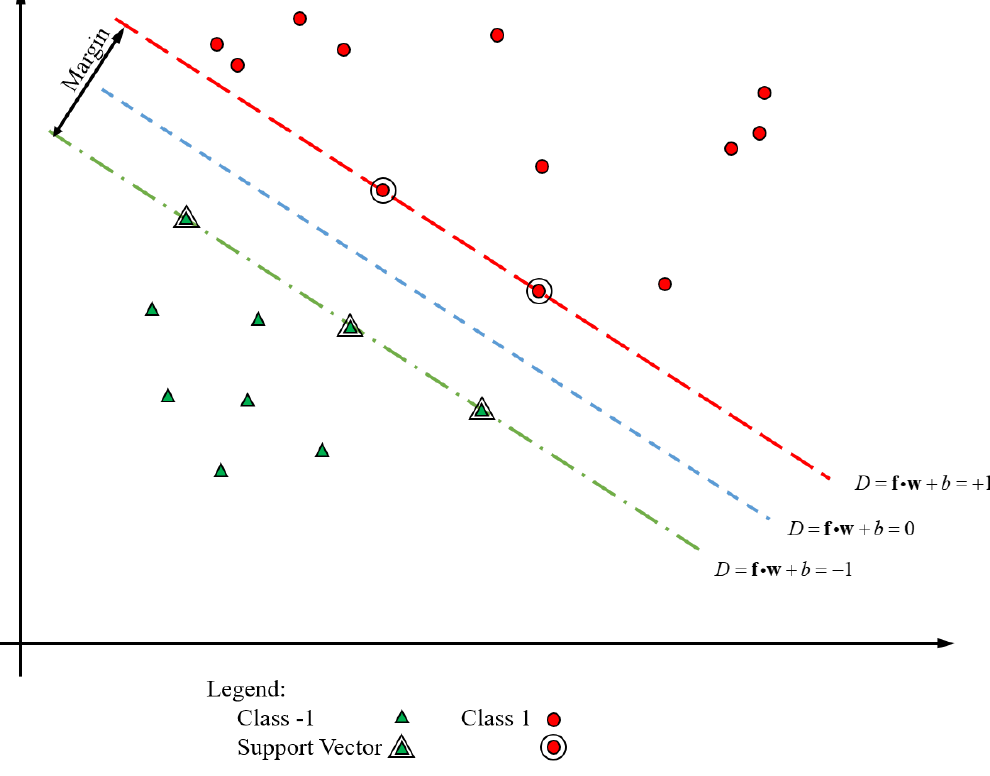
Figure 13. SVM 2D example. The margin is the distance from the D = − 1 to D = 1